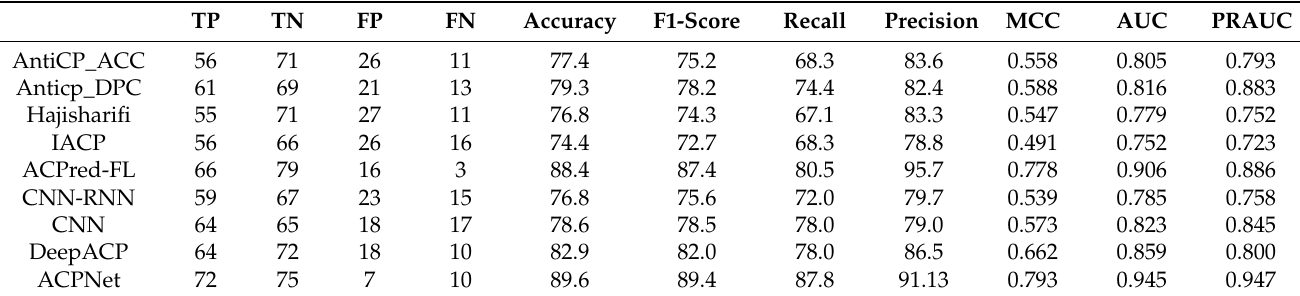
Table 5. Performance comparisons of ACPNet with the existing